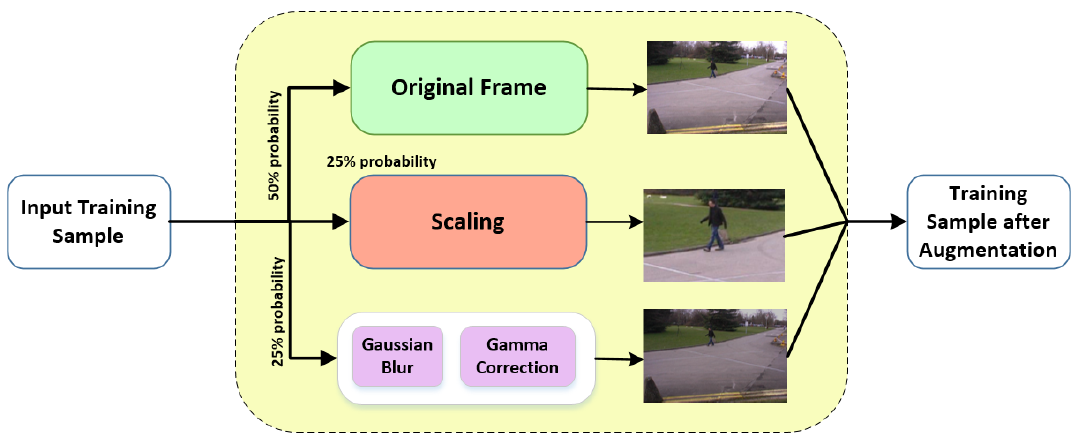
Figure 3. While training the network, the samples are randomly selected from the training set. With 50% probability, the original training sample is used for training. With the other 50% probability, it can go through two types of augmentation i.e., either scaling of light intensity variation. Scaling is introduced by cropping a random region in the original frame. While light intensity variation, first Gaussian blur is applied and then gamma correction is